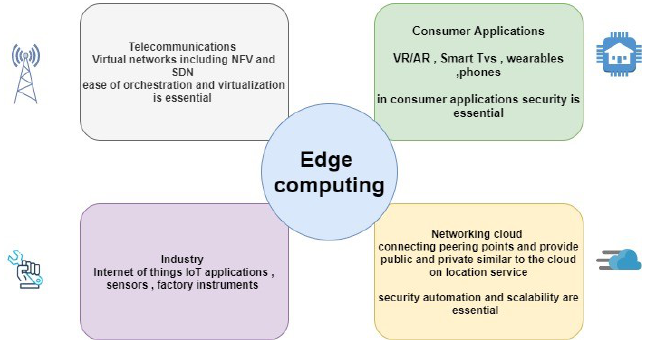
Figure 3. Edge computing